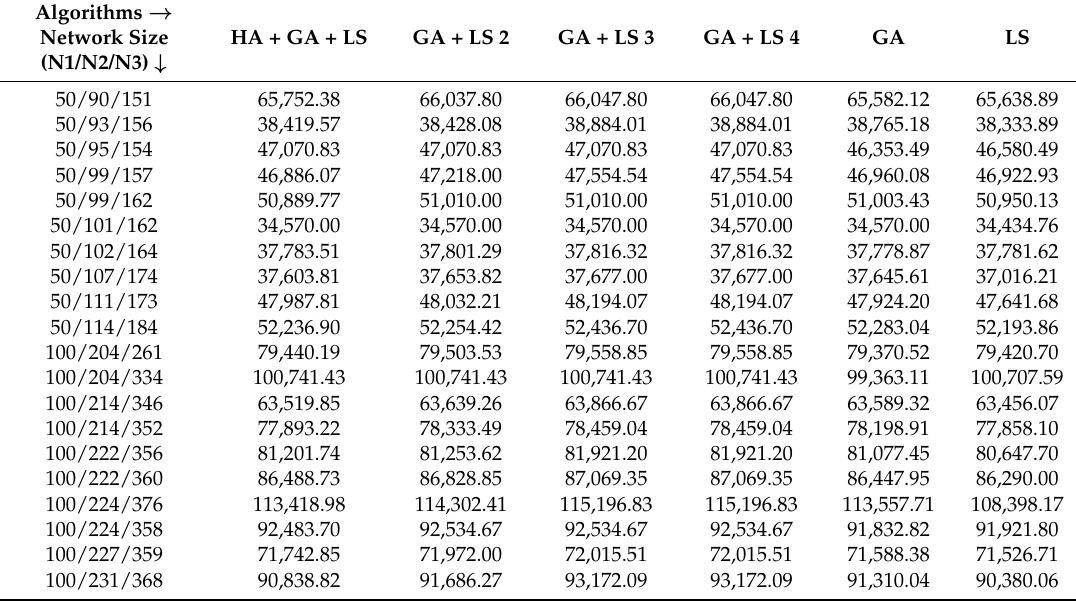
Table 5. Computational results of the multi-optimization for the artificial networks with different